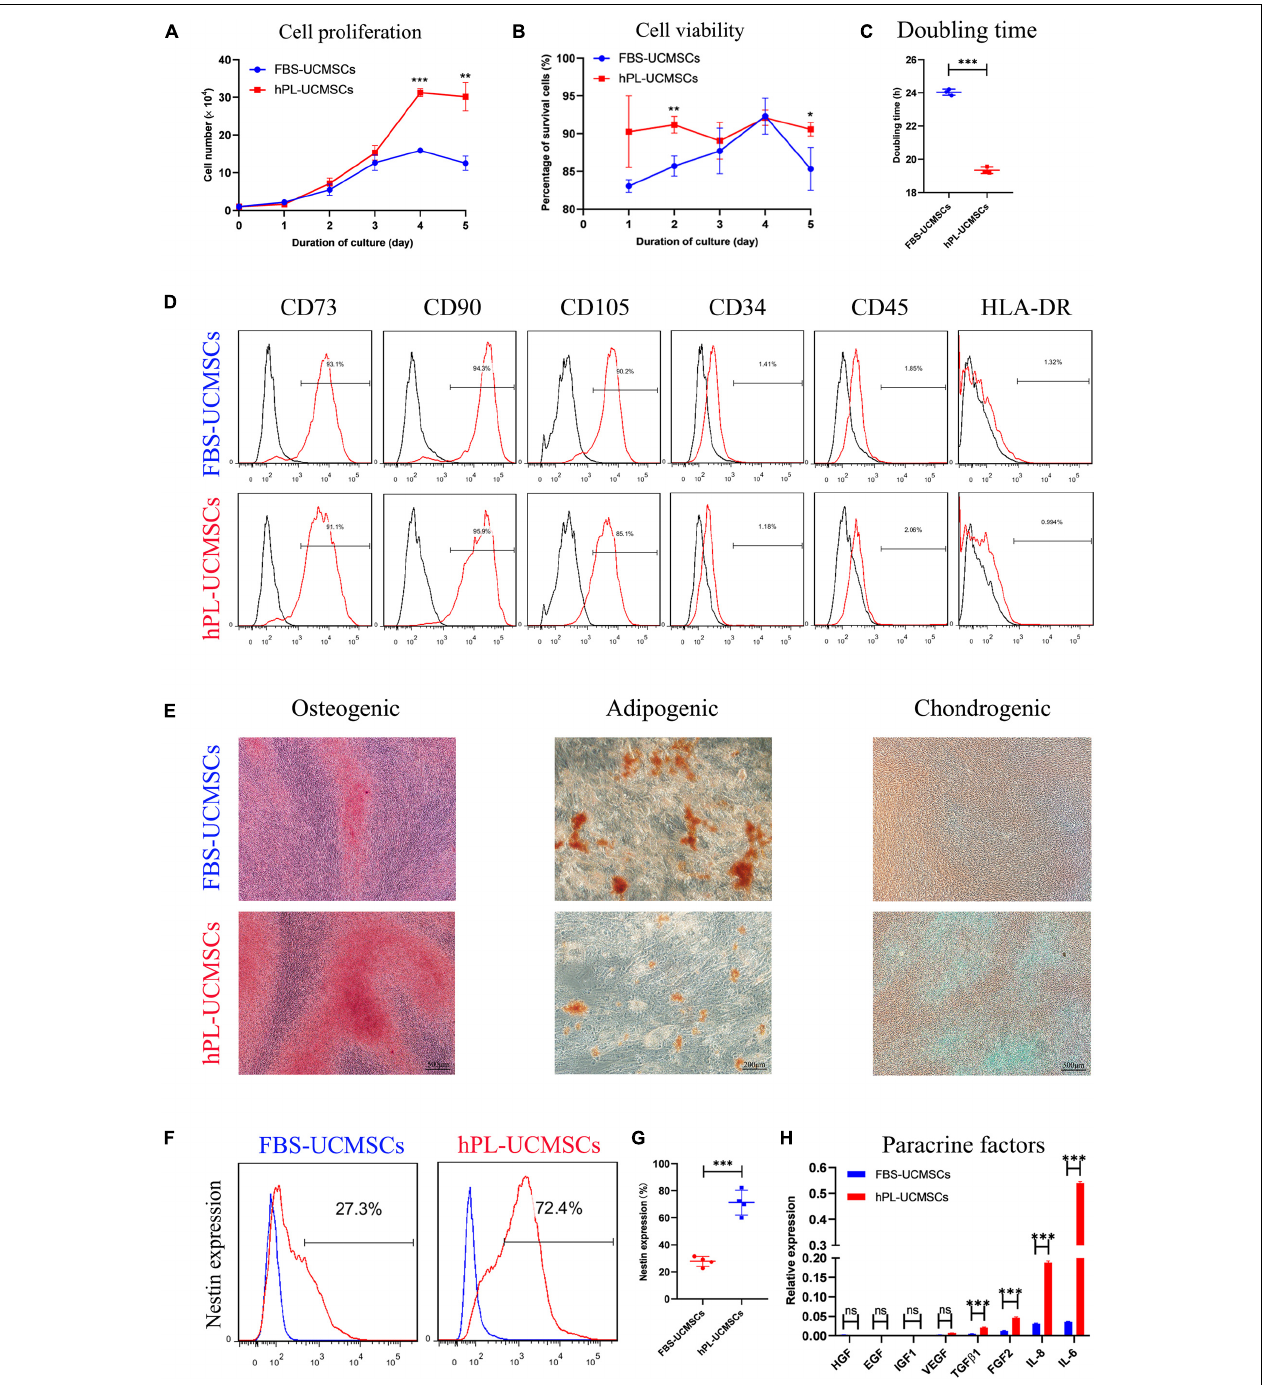
FIGURE 2 | Growth supplement hPL maintain the stemness of UC-MSCs in vitro expansion compared with FBS. (A) Growth curves of P4 FBS-UCMSCs and hPL-UCMSCs were assessed by direct counting for 5 days. Three replicates were performed at each time point. (B) The cell viability of FBS-UCMSCs and hPL-UCMSCs in each point was investigated. (C) P4 UC-MSCs cultured with hPL represented lower doubling time (DT) than that in FBS, as analyzed by a formula: DT = t × [log 2/(log N t –log N 0 )], where N t is the number of harvested cells, N 0 is the number of seeded cells and t is the culture time. (D) The expressions of cell surface makers on P4 FBS-UCMSCs and hPL-UCMSCs were detected by flow cytometry. (E) Representative stained images showed the osteogenic, adipogenic, and chondrogenic potentials of P4 FBS-UCMSCs and hPL-UCMSCs, as confirmed by Alizarin red, Oil red O, and toluidine blue, respectively. Scale bars, 200 or 500 µ m. The Nestin expression of FBS-UCMSCs and hPL-UCMSCs at P4 was analyzed by flow cytometry (F) ; and the percentage of Nestin + cells in the two groups was showed (G) . (H) The paracrine factors (growth factors and chemokines) that expressed by P4 FBS-UCMSCs and hPL-UCMSCs were compared using qPCR. Data are shown as mean ± SEM. n = 3–4. ∗ p < 0.05, ∗∗ p < 0.01, ∗∗∗ p < 0.001.